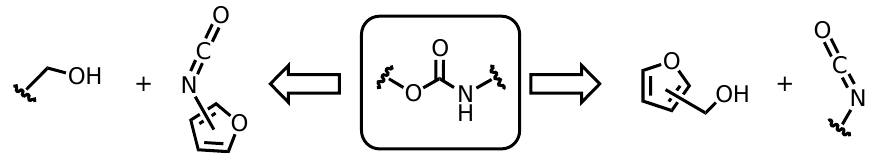
Figure 3. Assembly of carbamate functionality.